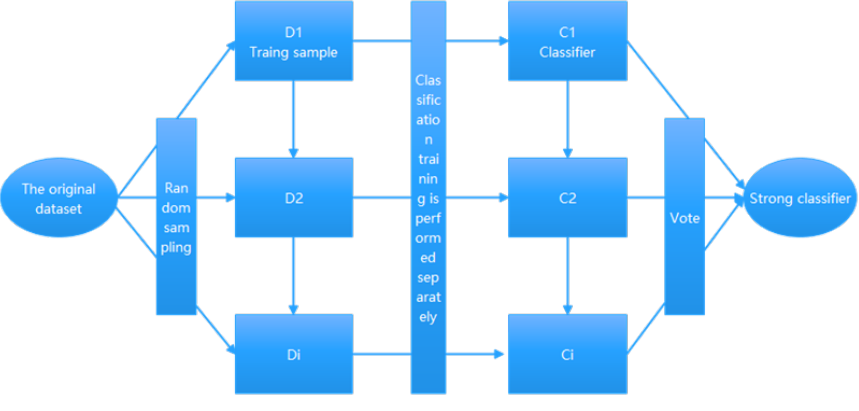
Figure 2. The basic flow chart of the random forest.